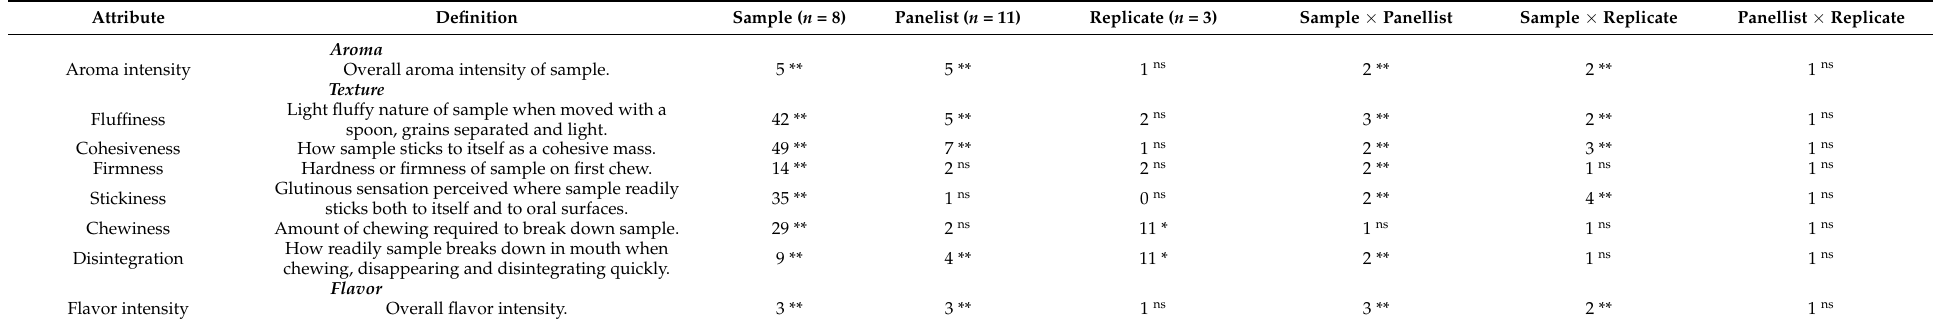
Table 3. Summary of sensory attribute terms, their corresponding definitions, and statistical analysis 1